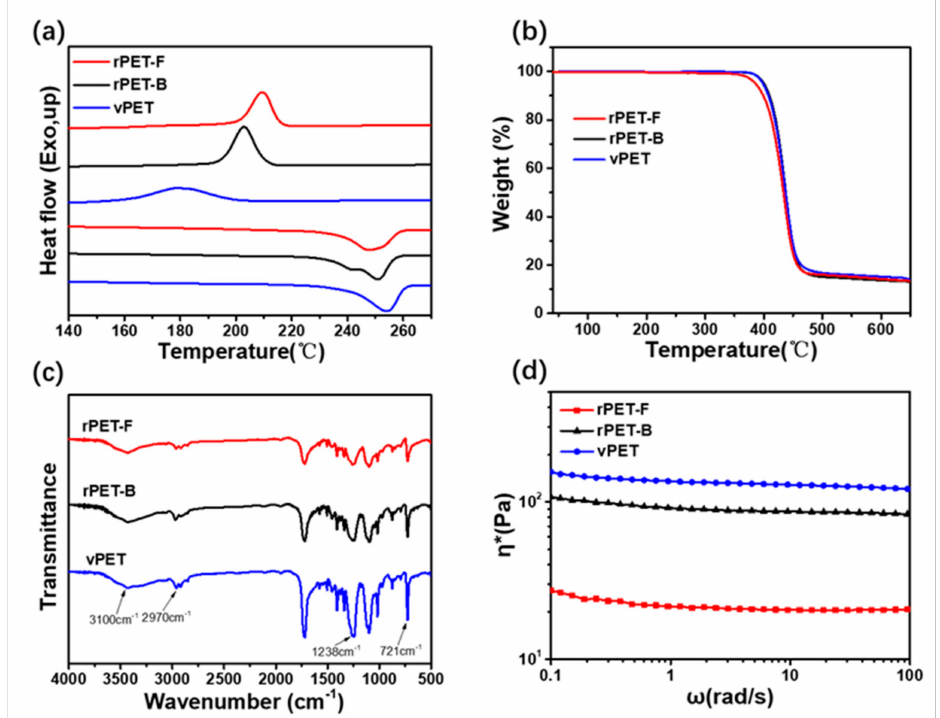
Figure 1. ( a ) DSC curves, ( b )TGA curves, ( c ) FTIR spectra and ( d ) complex viscosity as function of frequency of rPET-F, rPET-B and